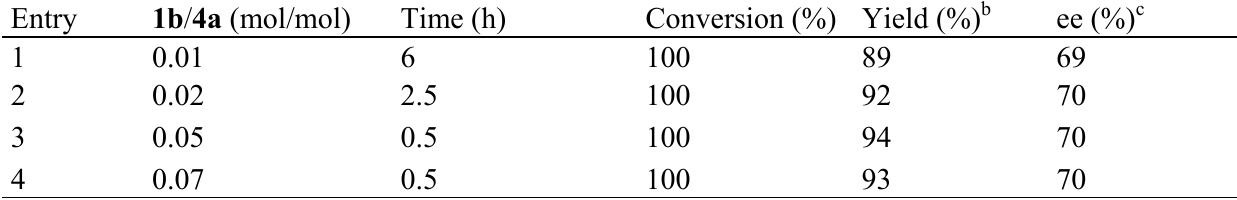
Table 3. Effect of the molar ratio of 1b / 4a on glyoxylate-ene reaction of 4a with 5a a .